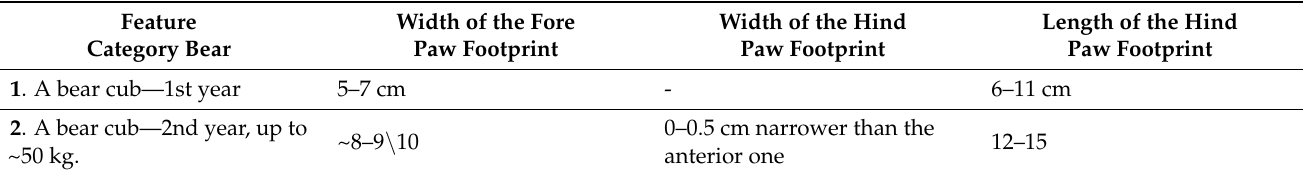
Table 2. Size of the footprints of the brown bear from Bulgaria. Congruence between the length of the footprint of the hind paw, the width of the fore paw, and the size, sex, and age of the bear (from source